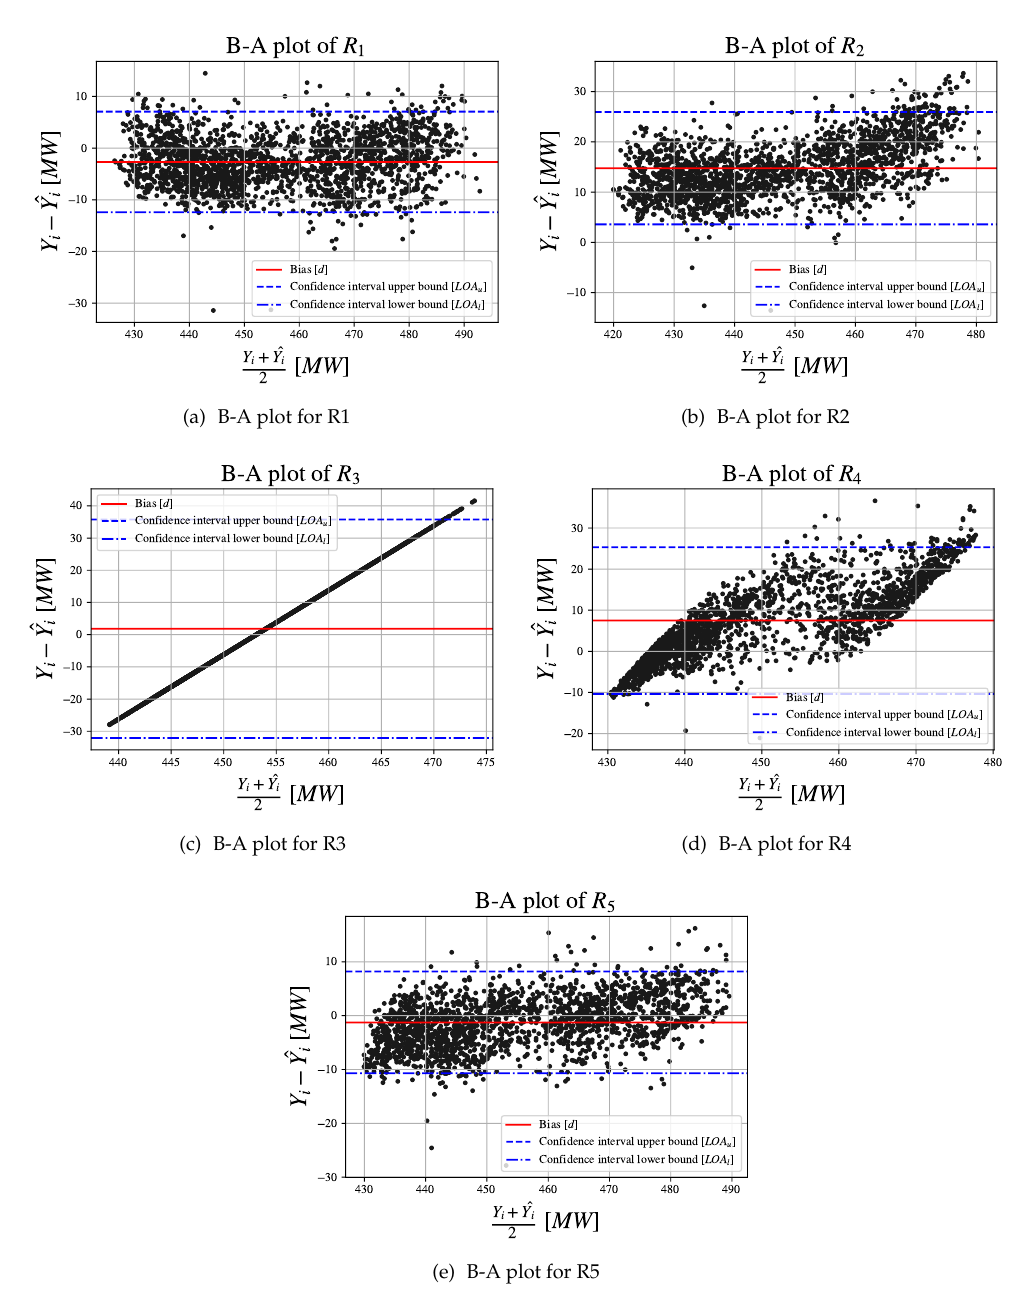
Figure 5. Bland-Altman plots for all five MLP configurations designed with GA implementation with MRE as a fitness